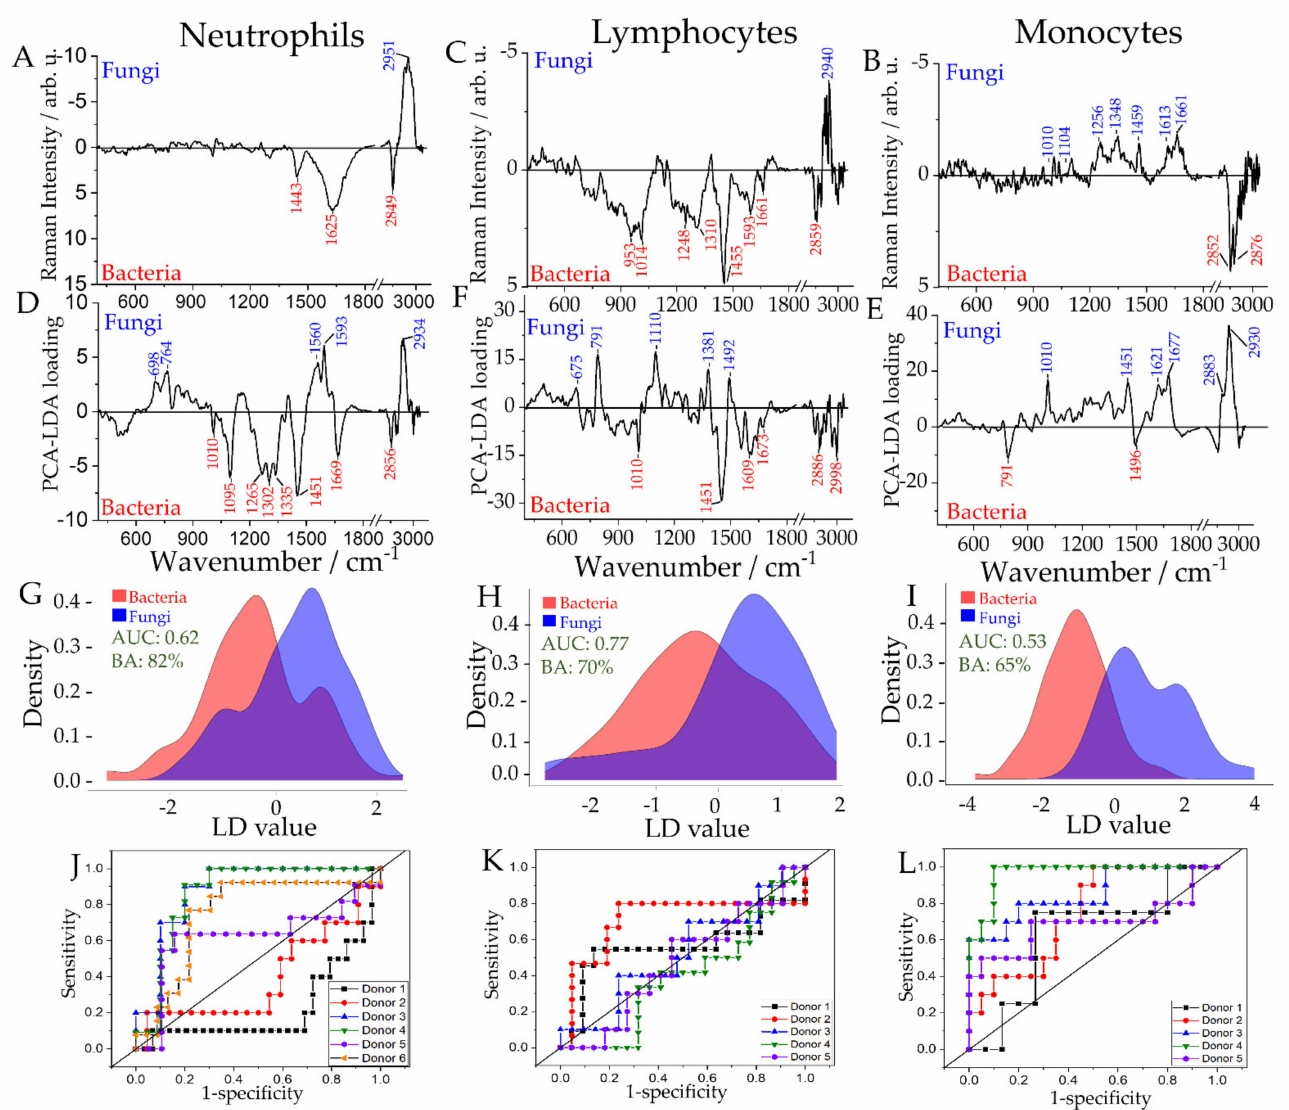
Figure 3. Raman spectroscopic analysis of in vitro stimulation of leukocyte subpopulations to differentiate fungal and bacterial infection. Raman spectra of pure subpopulations were recorded after neutrophils’ and PBMCs’ infection with K. pneumoniae , S. aureus , or C. albicans (Figure S1). Raman difference spectra ( A – C ), PCA loadings ( D – F ), distribution of fitted LD model scores ( G – I ), and ROC curves for the cross-validated predictions ( J – L ) are given for neutrophils ( A , D , G , J ), lymphocytes ( B , E , H , K ) and monocytes ( C , F , I , L ). The ROC curves ( J – L ) are calculated individually for each donor. Achieved balanced accuracy (BA) on the sample level and average AUC on the cell level for the PCA-LDA models are given as insets to the distribution of fitted LD model scores ( G – I